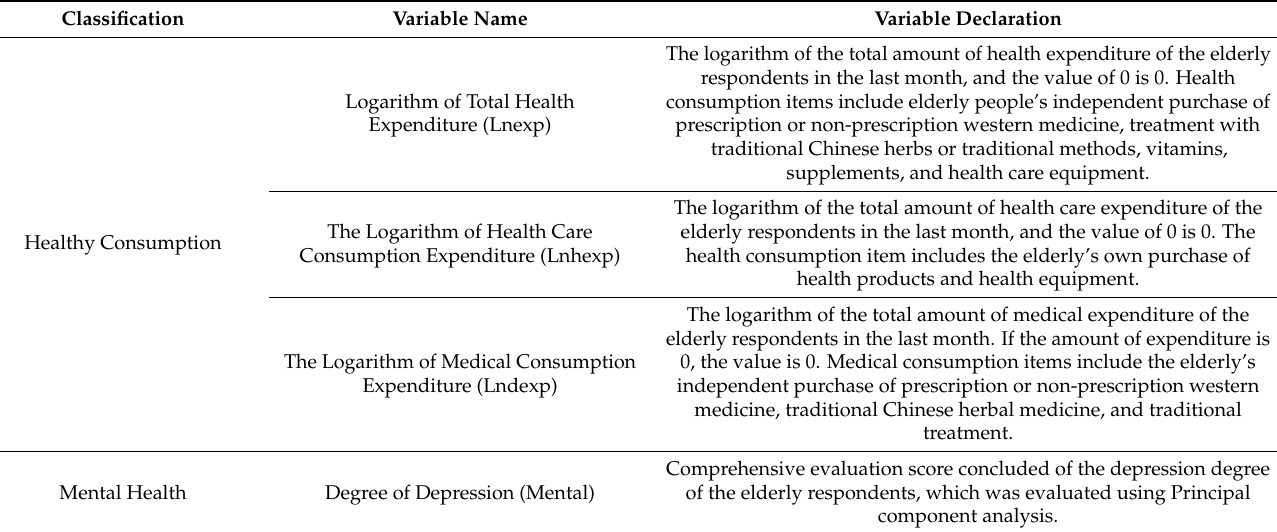
Table 3. Variable